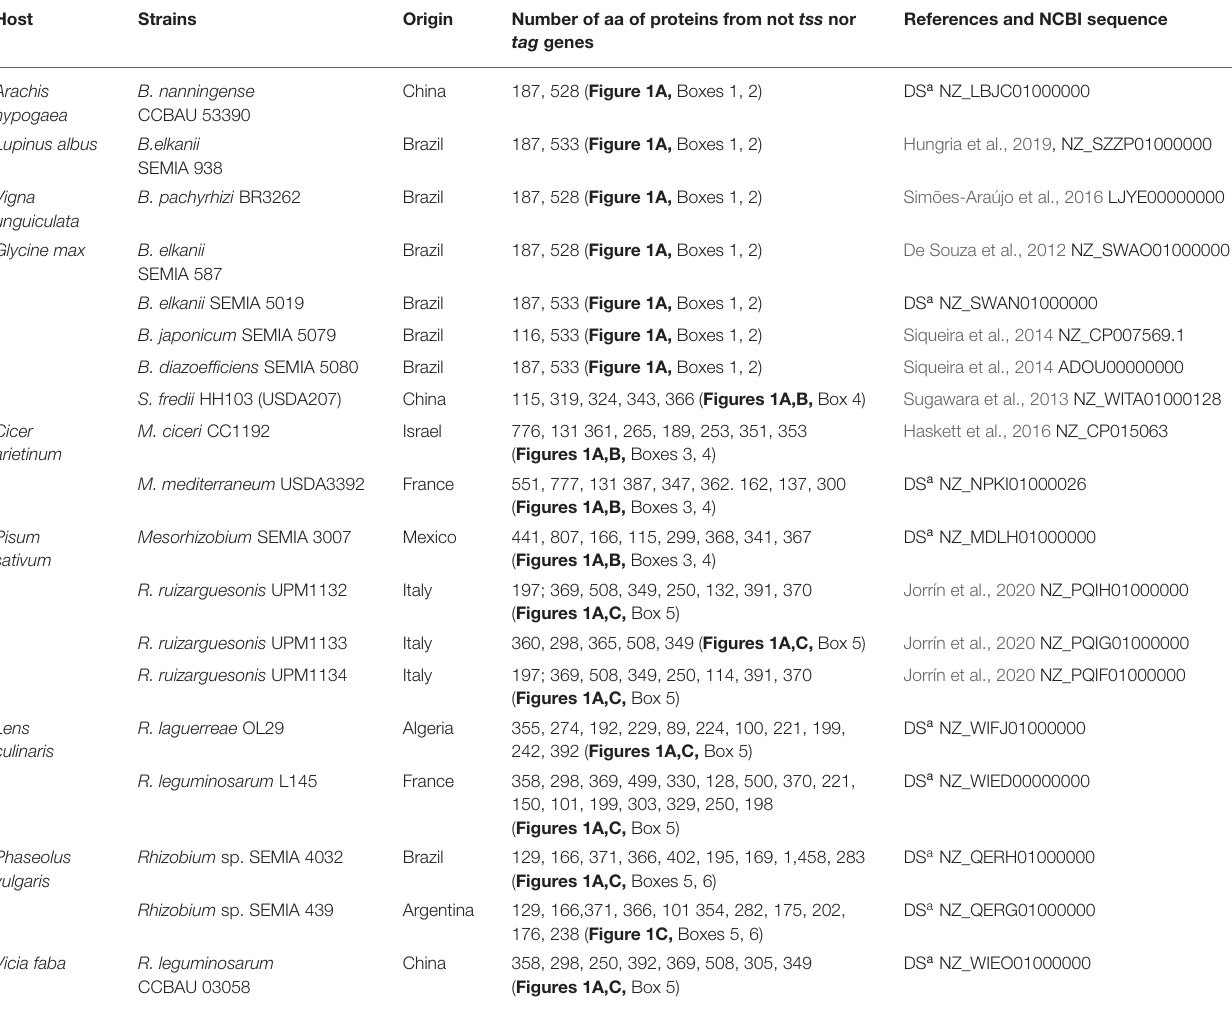
TABLE 1 | Proteins encoded by different rhizobial T6SS genes (no tss or tag